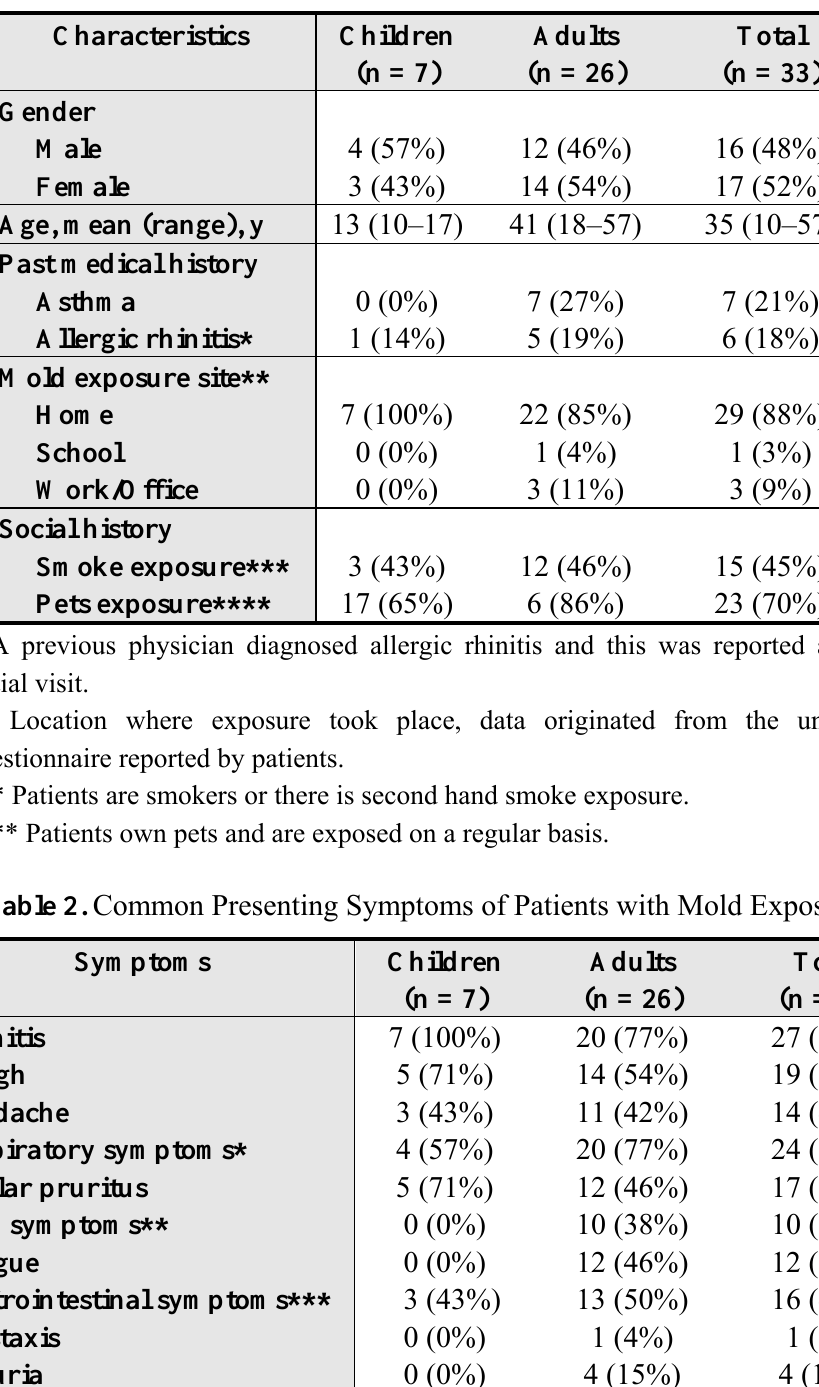
Table 1. Demographic Characteristics of Patients Reviewed (n = 33).